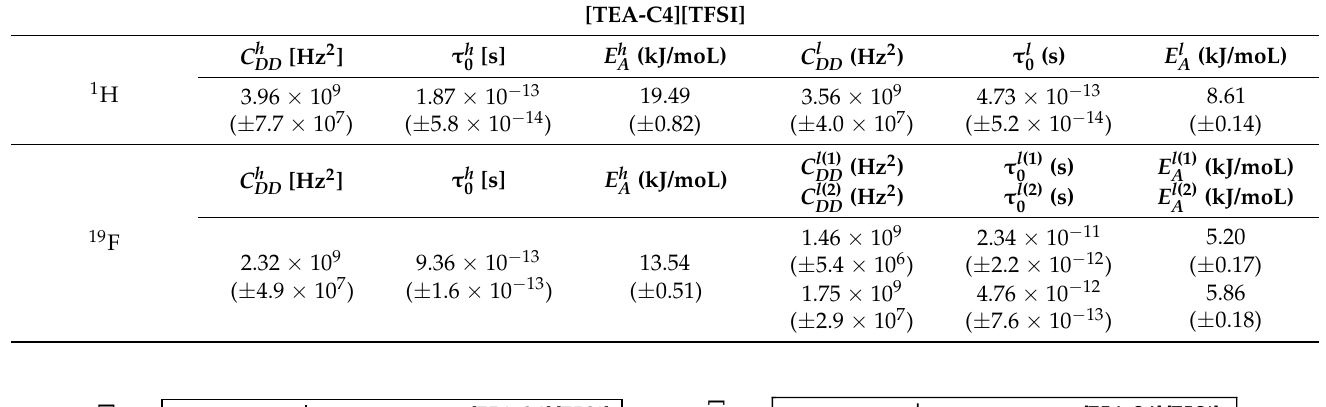
Table 1. Parameters obtained from the analysis of the 1 H and 19 F spin-lattice relaxation data for [TEA-C4][TFSI].